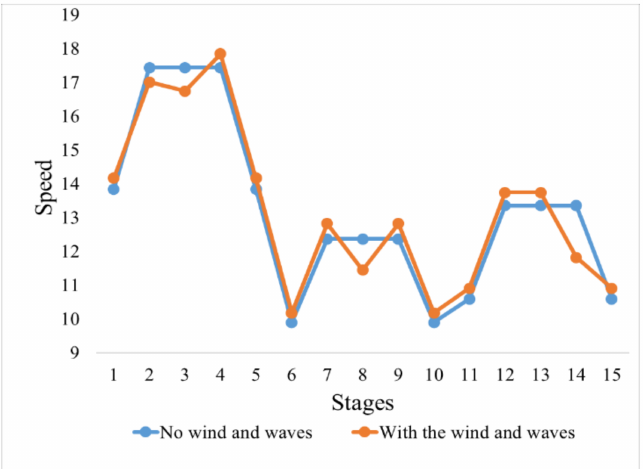
Figure 8. Speed comparison between calm and rough conditions.